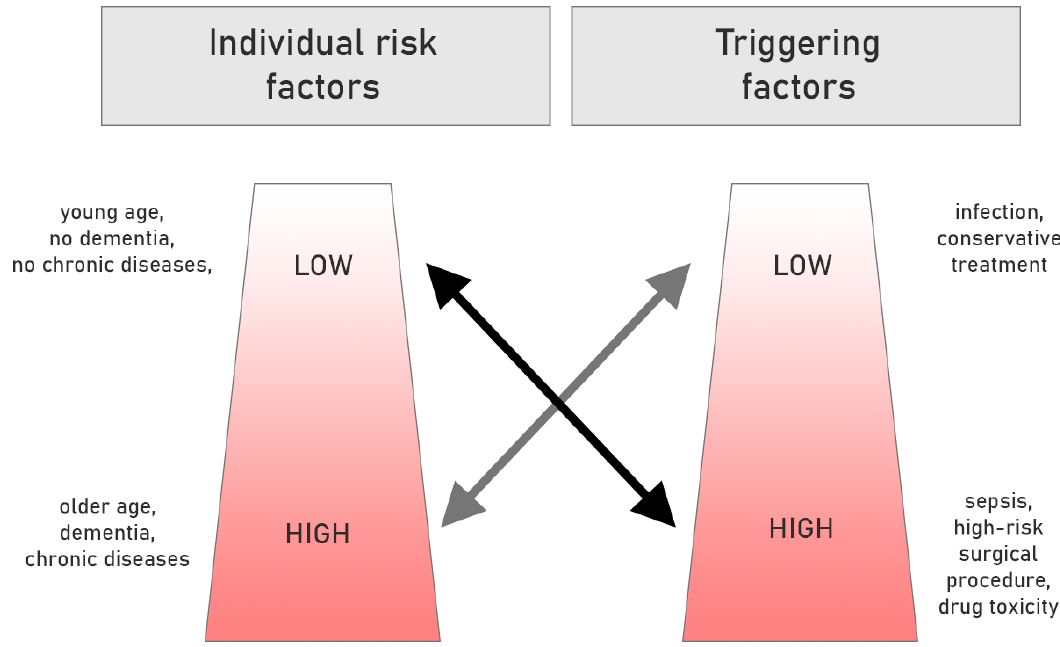
Figure 1. The role of predisposing and triggering factors in the occurrence of delirium. Based on [15,16] (with modification).